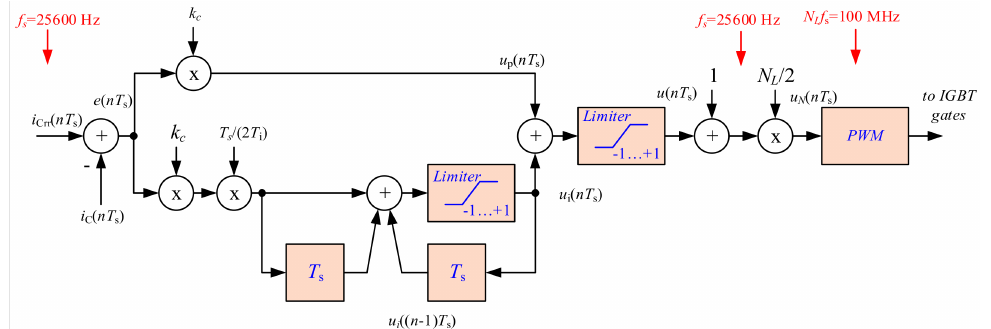
Figure 5. Simplified block diagram of digital PI current